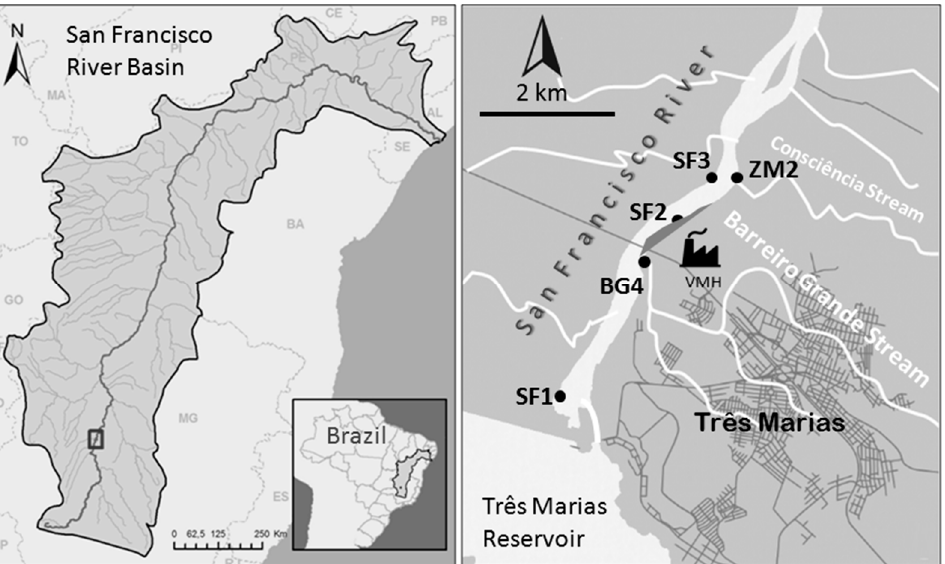
Figure 1. Map showing São Francisco River basin extension (Brazil) and study area with sampling stations (SF1, BG4, SF2, SF3, and ZM2). Some of the sources of contaminants, such as a factory, the city of Tres Marias, and the security dam (in dark grey), are also included.